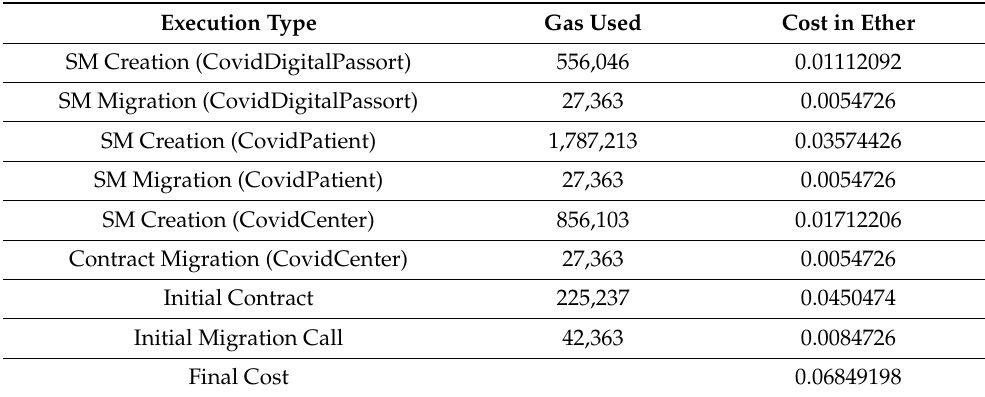
Table 2. Cost analysis for